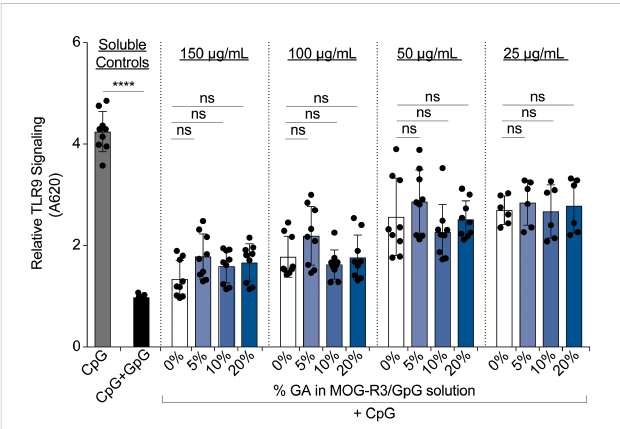
FIGURE 4 Cross-linked iPEMs maintain their ability to blunt TLR9 signaling. Relative TLR9 signal after 14-hour incubation with iPEMs. Data represents mean ± standard error mean of two to three independent experiments completed in triplicates. Statistical comparisons performed using two-way ANOVA followed by Dunnett ’ s multiple comparisons test between non-cross-linked and cross-linked iPEMs. Ns, not signi fi cant. Unpaired t-tests were used to compare soluble controls. ****p < 0.0001.